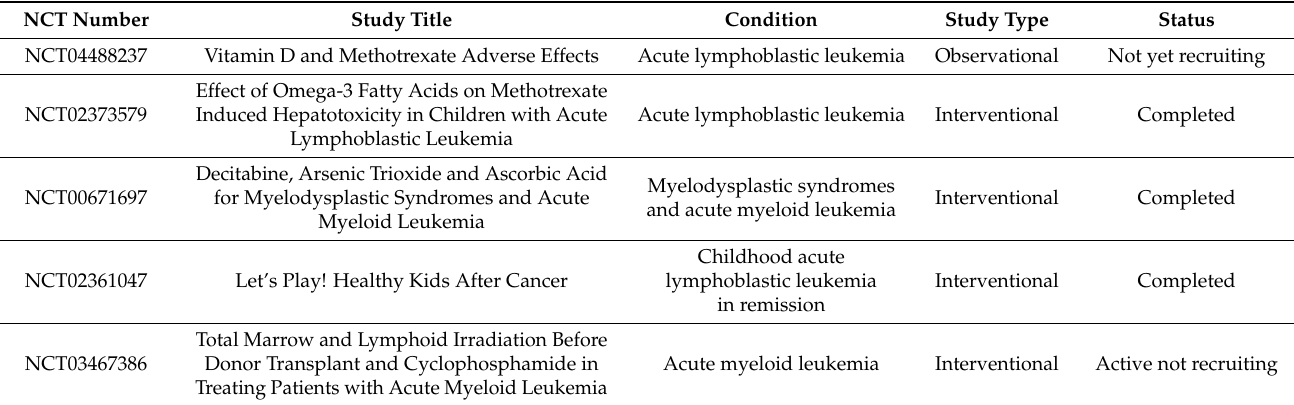
Table 1. Clinical trials evaluating the impact of oxidative stress on therapeutic treatment or on the onset of side effects of chemotherapy. www.clinicaltrials.com (accessed on 15 May